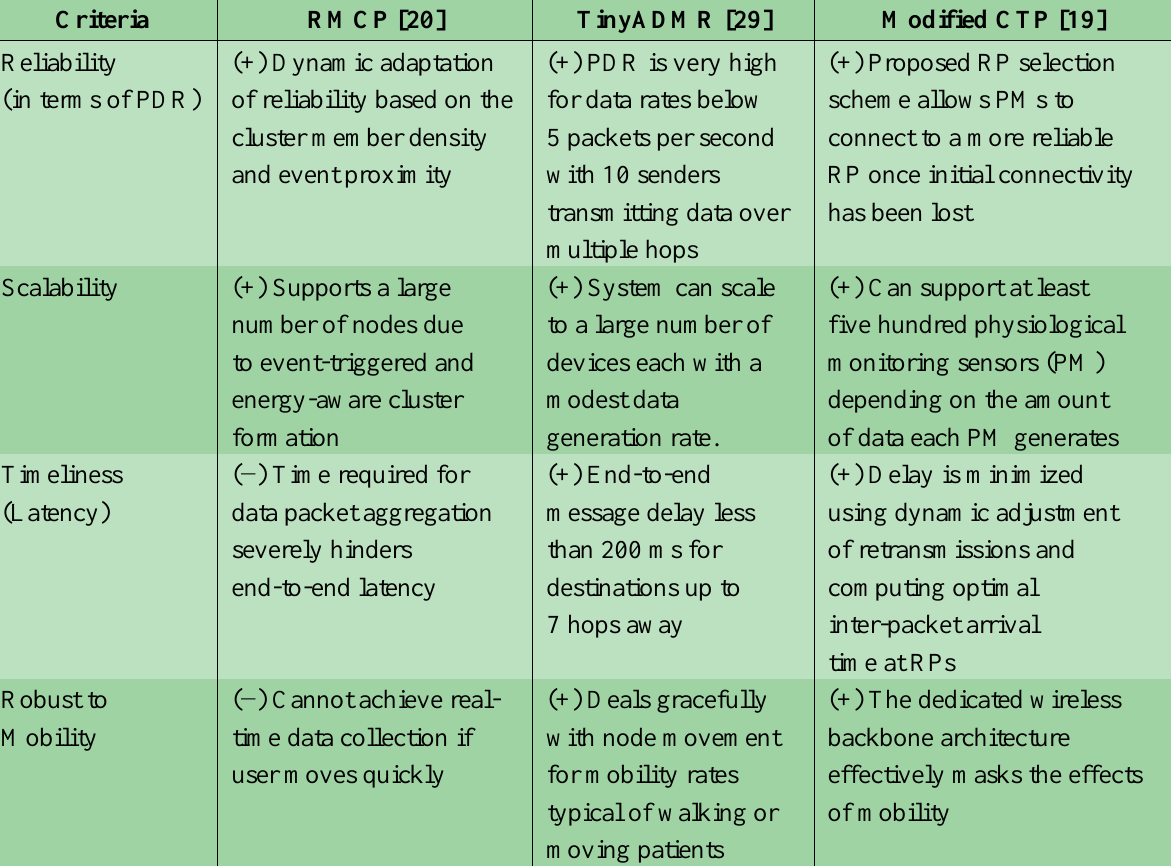
Table 3. Summary of routing protocols for